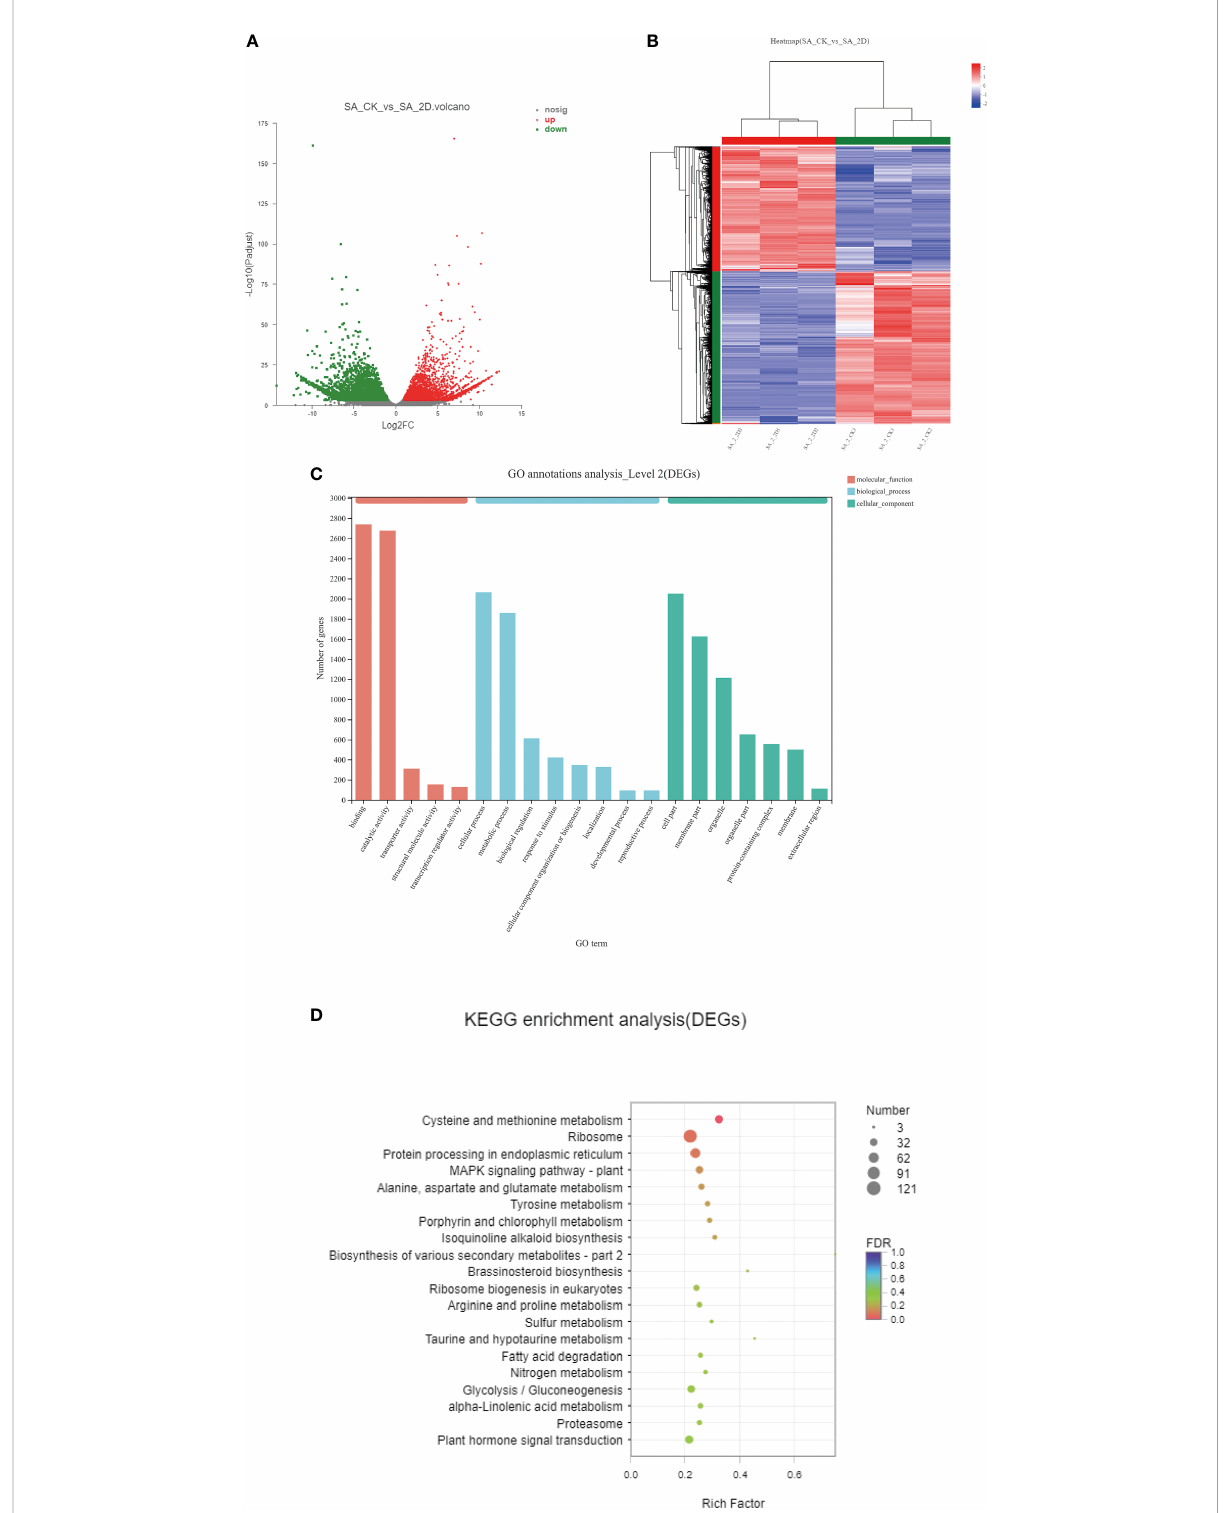
FIGURE 4 DEGs enrichment analyses. (A) DEGs volcano map between the SA_CK and SA_2D; (B) The hierarchical clustering of DEGs between the SA_CK and SA_2D; (C) GO enrichment analysis of DEGs; (D) KEGG enrichment analysis of